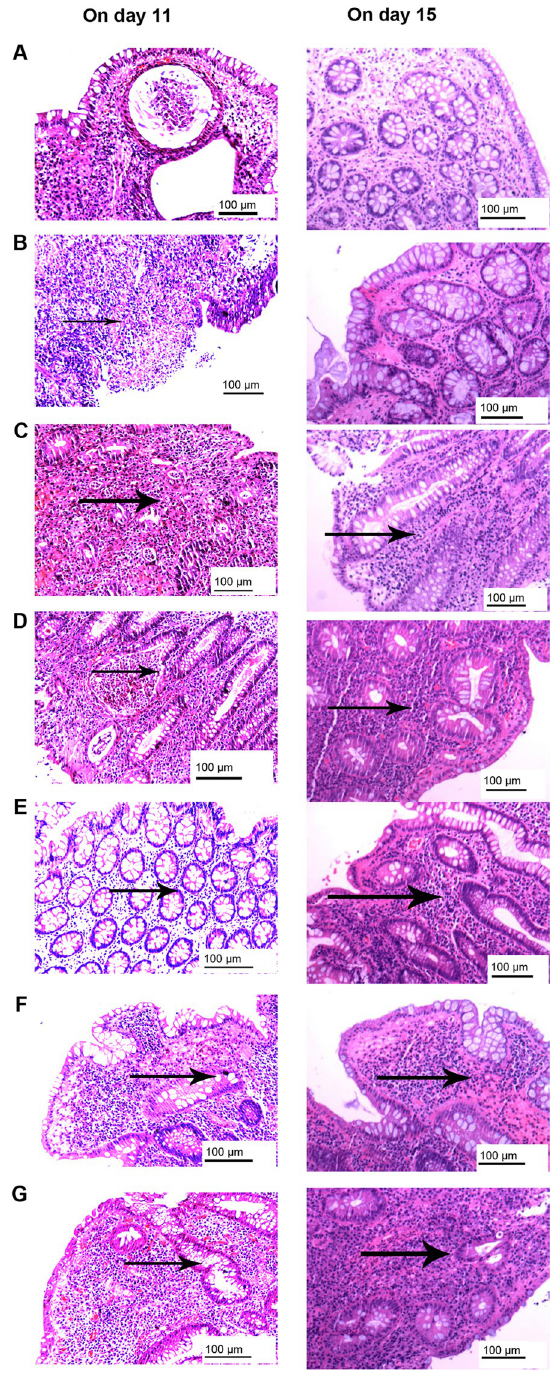
Fig 9. Pathological images of rectal tissue hematoxylin-eosin staining. Images from groups (A) A, (B) B, (C) C, (D) D, (E) E, (F) F and (G) G. Left, rat rectum tissue on day 11; right, rat rectum tissue on day 15. In group A, no obvious neutrophil infiltration and mucosal edema were observed. In groups B-G, neutrophil infiltration was severe, and marked mucosal edema was notable; additionally, mucosal necrosis was observed, and focal ulcers were formed.